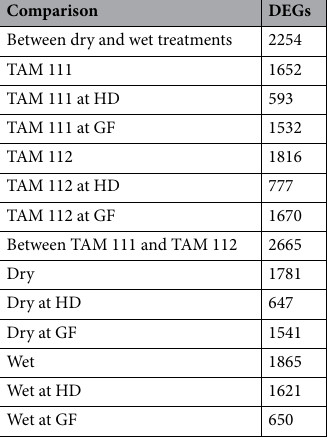
Table 1. Comparison of differentially expressed genes (DEGs) between dry and wet conditions within and between TAM 111 and TAM 112 at heading (HD) and grain filling (GF) stages.